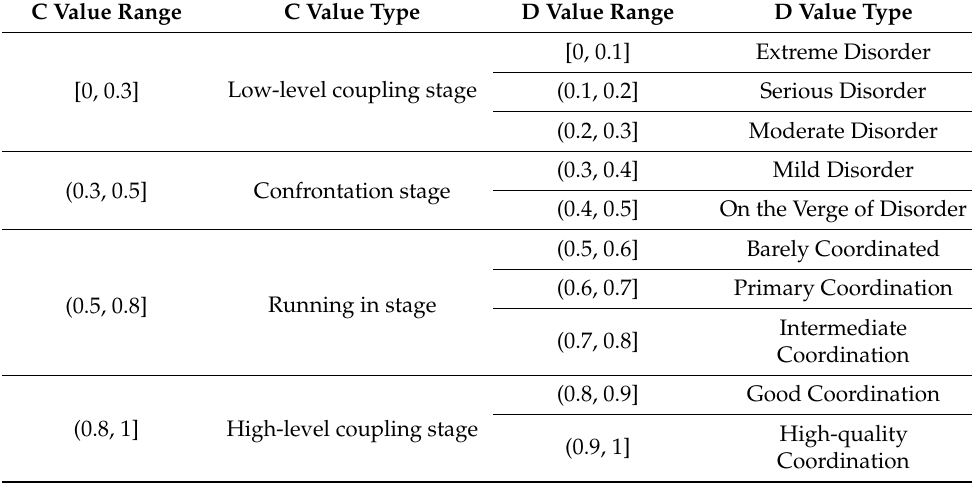
Table 3. Classification criteria of coupling degree and coupling coordination degree. C Value